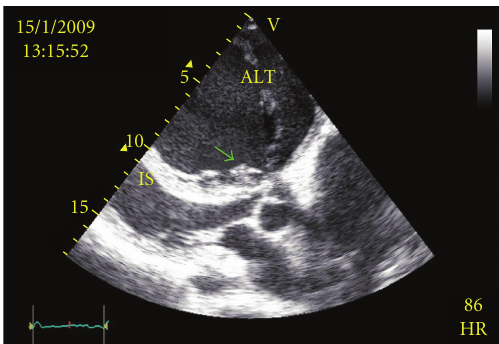
Figure 2: Transthoracic parasternal long-axis view demonstrating the septal leaflet apical displacement of the tricuspid valve (arrow), the “sail-like configuration” of the enlarged anterior tricuspid leaflet (ATL), and the leftward shift of the interventricular septum reducing left ventricle compliance